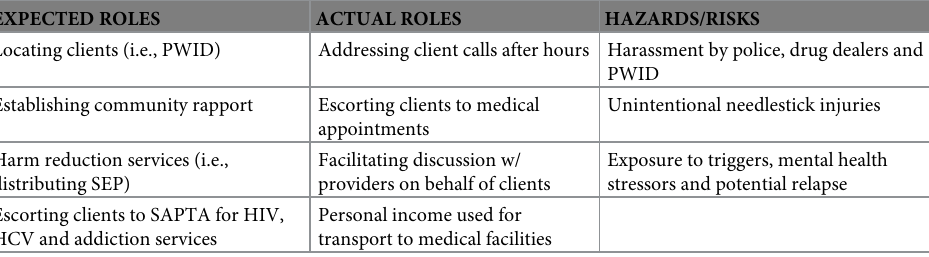
Table 2. Summary of occupational roles and risks of PE work in